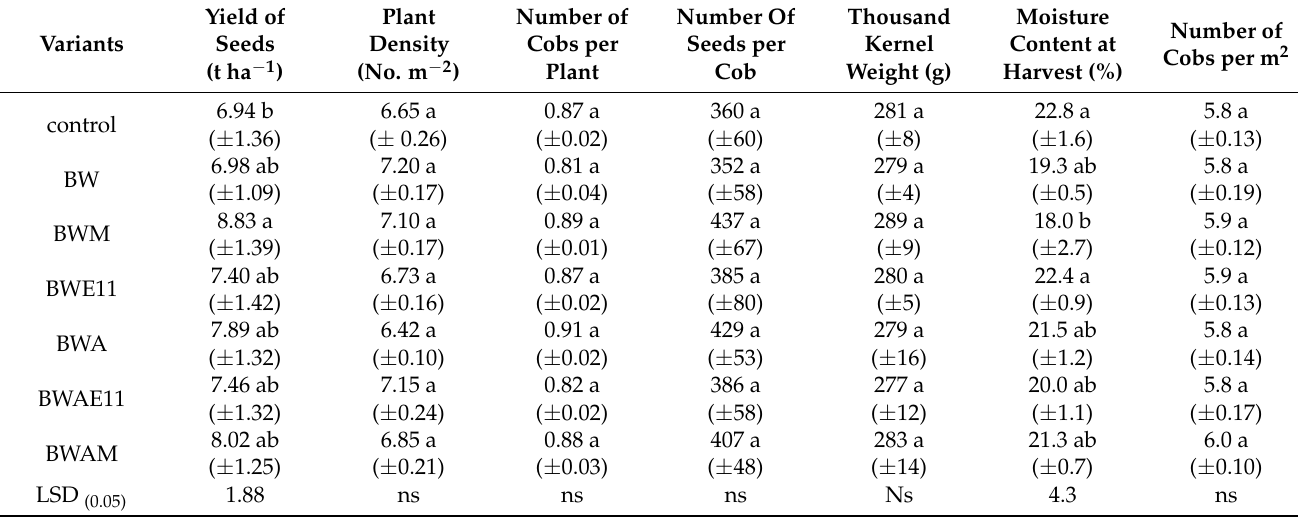
Table 4. The influence of the applied preparations on the yield of maize seeds and other yield